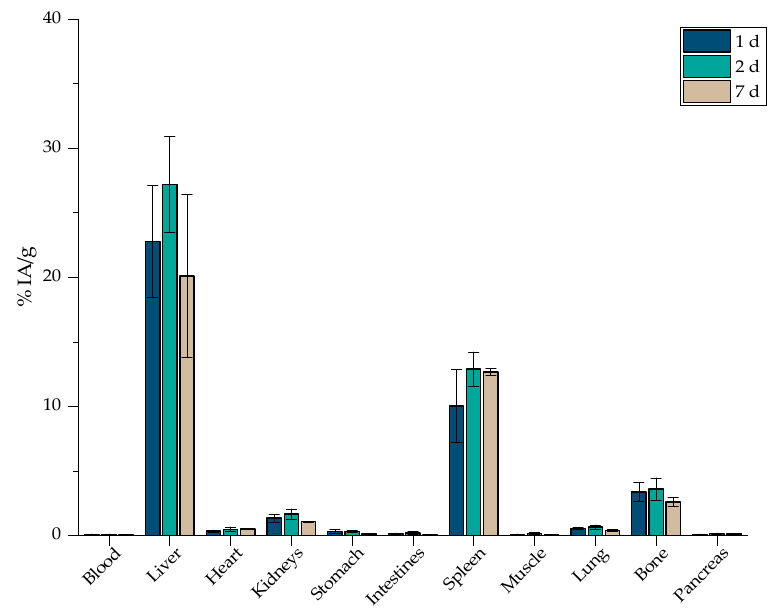
Figure 14. Biodistribution of [ 177 Lu]Lu-MAPEG in normal mice expressed as % IA/g ( n = 3).